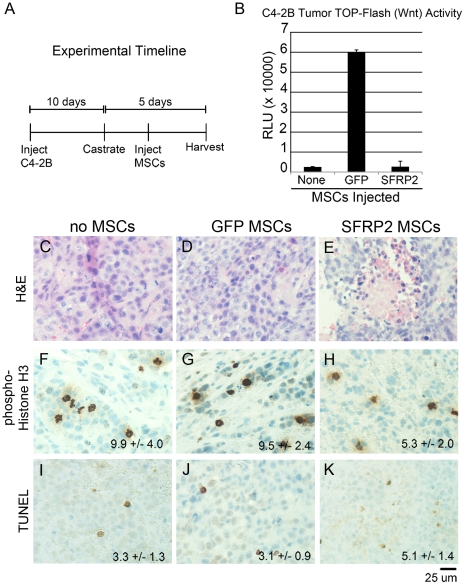
GFP-MSCs recruited to human CRPC xenografts enhanced Wnt signaling.A) The experimental setup is summarized in the timeline. C4-2B cells were orthotopically injected into the prostates of SCID mice. After 10 days the mice were castrated and MSCs were given 24 hours following castration. The tumors were harvested five days following castration. B) TOP-Flash luciferase activity was measured in C4-2B tumors. GFP-MSCs increased Wnt activity within the tumors by 24-fold compared to control uninjected tumors. SFRP2-MSCs suppressed Wnt activity comparable to basal levels. C4-2B tumors were sectioned and stained for histological analysis five days following castration. C4-2B tumors had necrosis in the C) absence of MSCs, D) GFP-MSCs, and E) the greatest in SFRP2-MSC injected mice. F) Basal levels of phosphorylated histone-H3 were observed in tumors without MSCs and G) GFP-MSCs. H) Proliferation was significantly decreased in tumors with SFRP2-MSCs (p value  = 0.0069). I) Basal levels of TUNEL-positive apoptosis were found in tumors without MSCs and J) GFP-MSCs. K) A significant increase in apoptosis was seen in tumors with SFRP2-MSCs (p value  = 0.0066). Areas of necrosis were avoided in quantitating TUNEL positive cells.